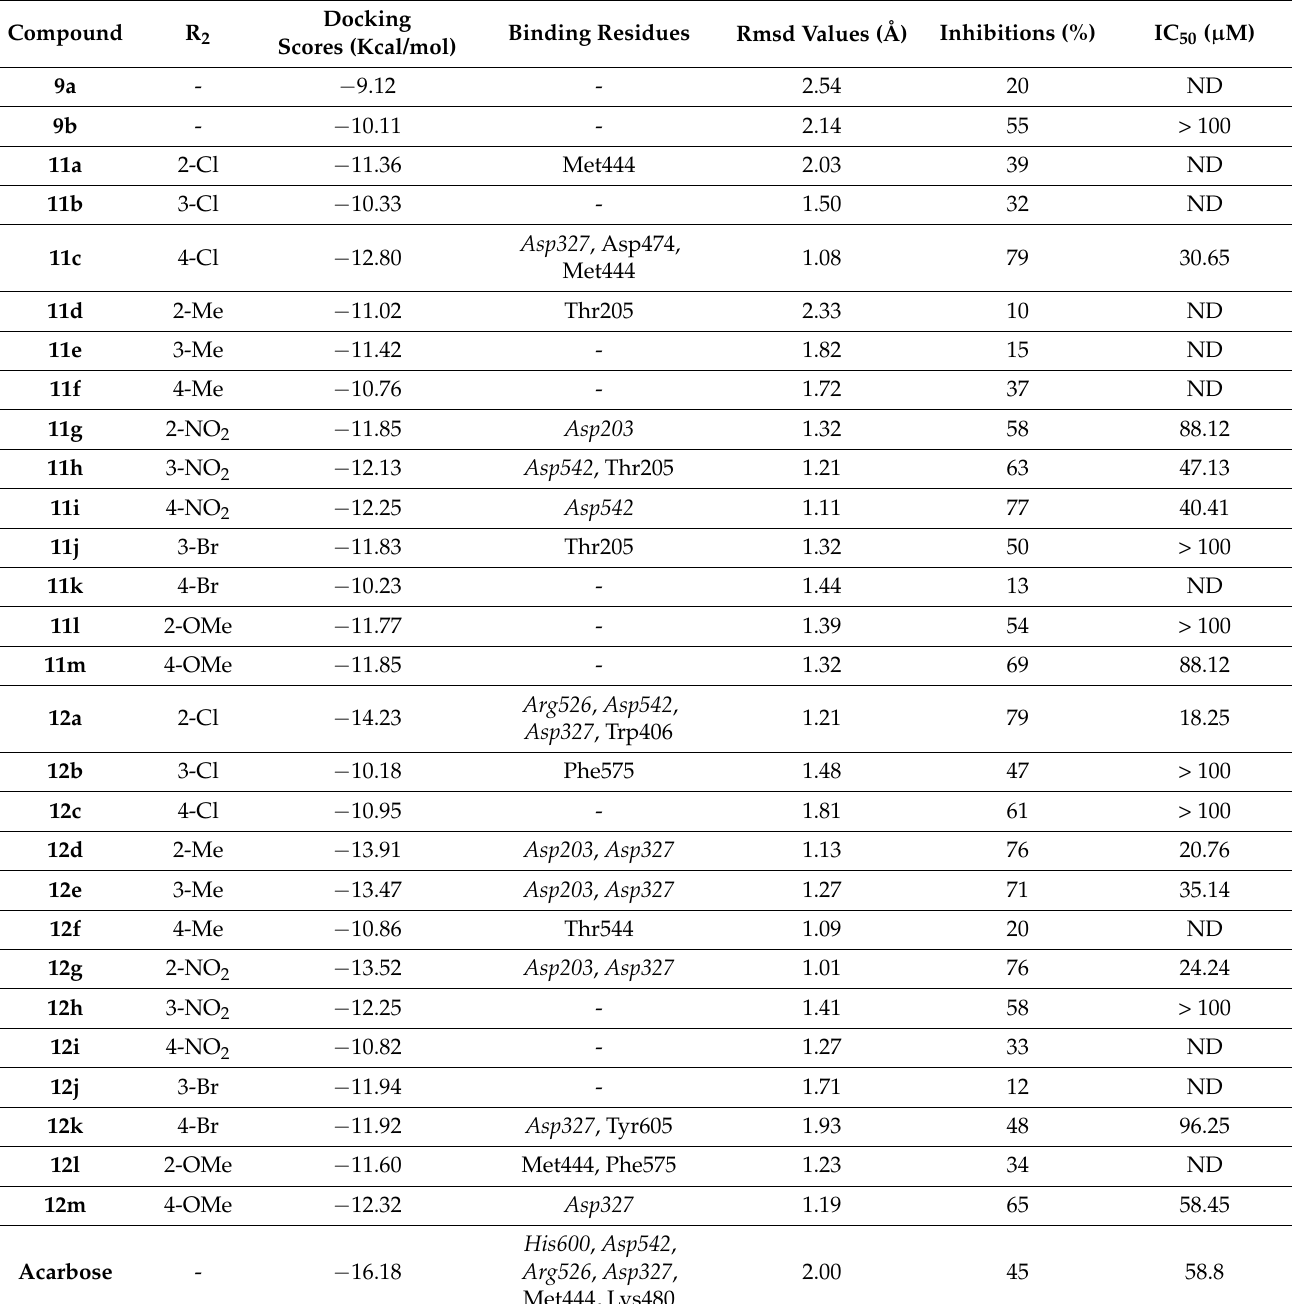
Table 1. Structural parameters, in silico (docking scores, binding residues, and rmsd values) and in vitro (IC 50 val- ues) inhibitory potential of 1,2-benzothiazines 9a , b , 1,2-benzothiazine- N -arylacetamides 11a – m , and 12a – m against α -glucosidase